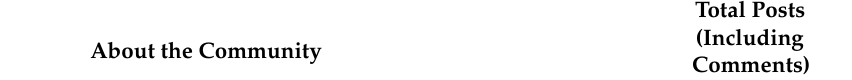
Table 1. Subreddits